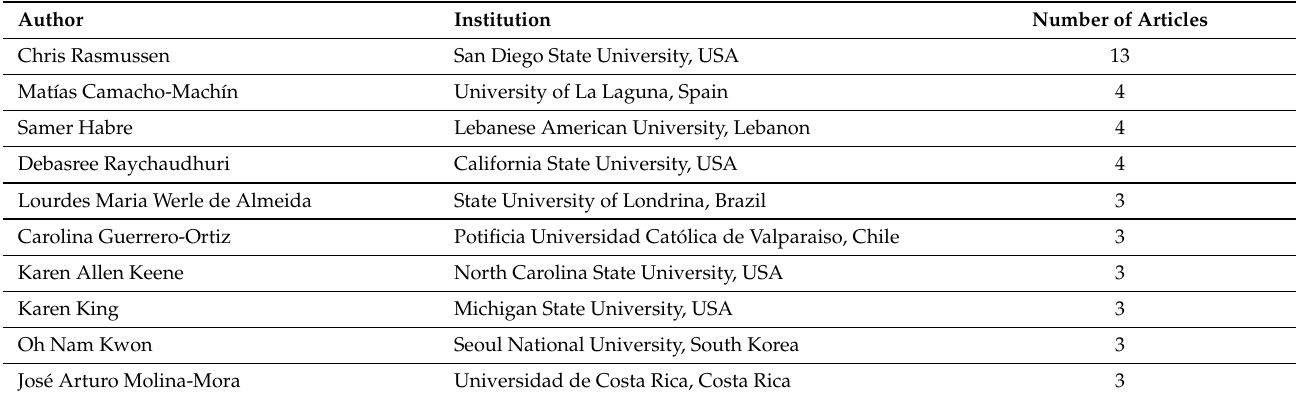
Table 4. Authors with the highest number of articles in the retained list.